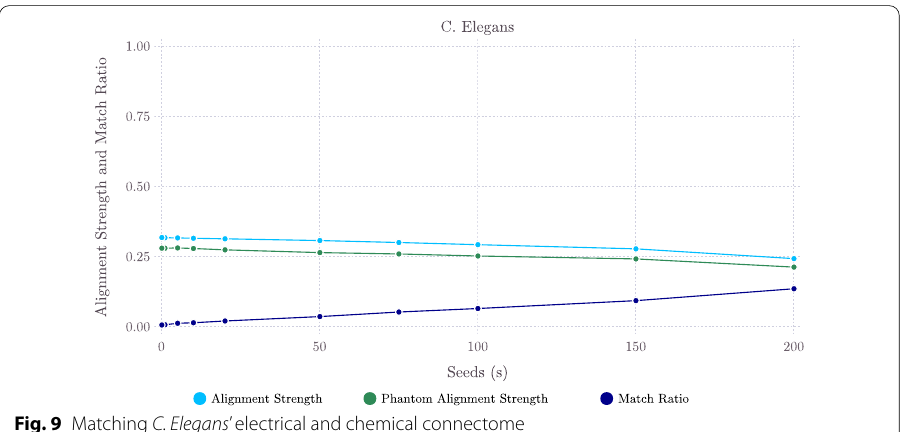
Fig. 9 Matching C. Elegans ’ electrical and chemical